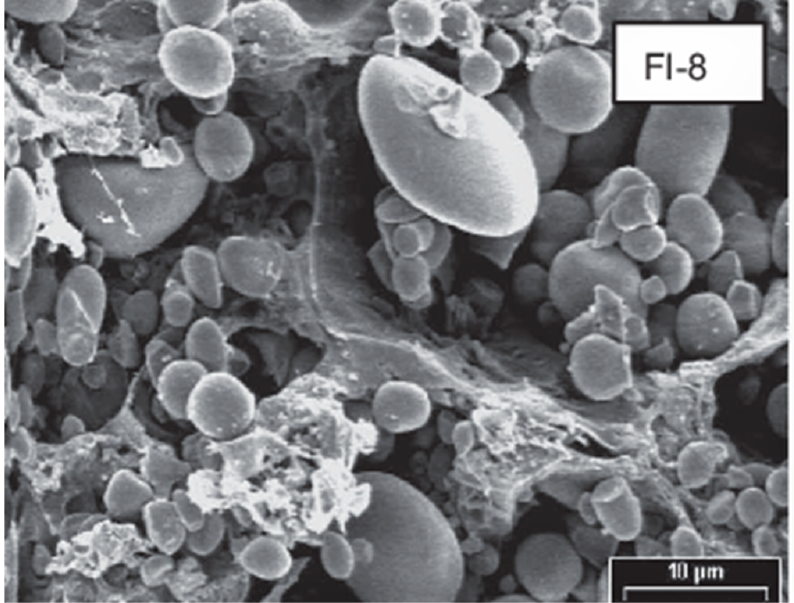
Figure 2. Scanning electron micrograph of the gluten dough prepared in Brabender Farinograph from a wheat flour after 8 min. of mixing (FI-8, magnification: 2600 × ). Adapted from [7]. 2. Raw Materials for Gluten-Free Bread and Bakery Products The specific technological properties of typical gluten cereals in the production of gluten-free bread and bakery products need to be replaced. Rice, corn, or sorghum and other gluten-free cereals are the basis of the diet in many countries around the world. For the preparation of bread and bakery products from gluten-free raw materials, it is necessary to ensure the volume and cohesion of the dough. Rapid staling of these products is a big problem. The nutritional value of wheat and gluten-free bread can be different. Table 1 shows the comparison of nutritional values between wheat flour and gluten-free bread baking mixtures (or flour, respectively) and Table 2 the composition of fresh gluten- containing and gluten-free buns. The nutritional values strong depend on the raw material composition of these products and are not uniform. Table 1. Nutritional values of wheat flour and gluten-free bread baking mixtures. The values were obtained from the product packages or available on https://itesco.cz/ (accessed on 24 January